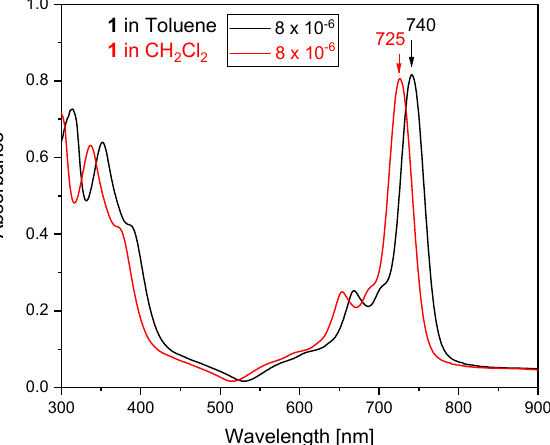
Figure 6. Electronic absorption spectra of antimony(III) phthalocyanine ( 1 ), [(SbPc) 4 (Sb 6 I 16 Br 6 )], in toluene (black) and CH 2 Cl 2 (red) solutions.